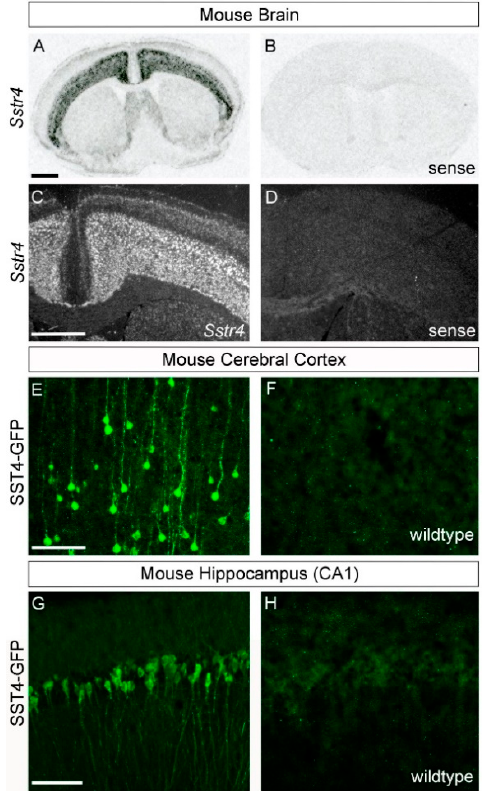
Figure 1. Sstr4 expression in the mouse brain. ( A , B ) X-ray autoradiograms show coronal brain sec- tions after in situ hybridization (ISH) with 35 S-labeled Sstr4 antisense ( A ) and Sstr4 sense riboprobes ( B ). ( C , D ) Darkfield micrographs show the cerebral cortex in emulsion-dipped sections after ISH with 35 S-labeled Sstr4 antisense ( C ) and Sstr4 sense riboprobes ( D ). ( E – H ) Confocal images show the cerebral cortex ( E , F ) and hippocampal subregion CA1 ( G , H ) of SST4-GFP ( E , G ) and wild-type mice ( F , H ) after anti-GFP immunostaining. Scale bars: ( A , C ) 1 mm; ( E , G ) 100 µm.